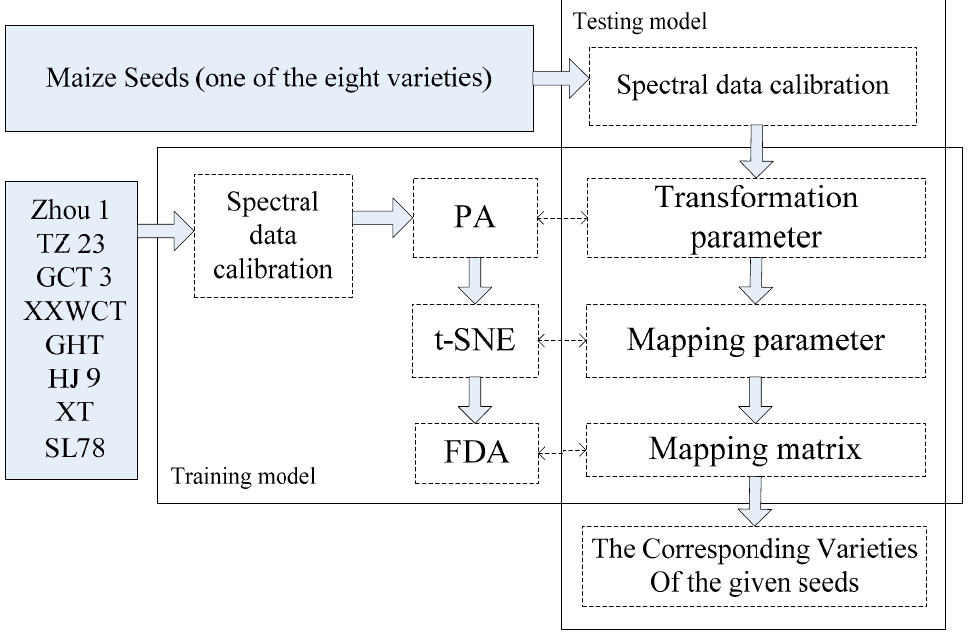
Figure 4. The detailed procedure of the training and testing model for variety classification of waxy maize seeds.